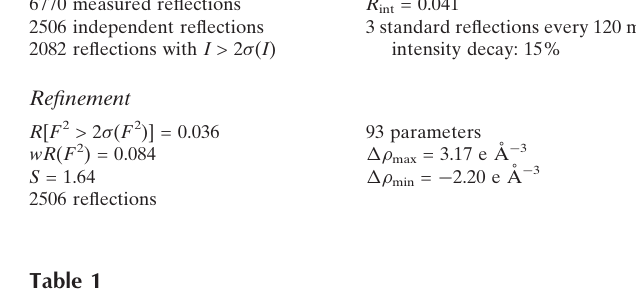
Selected bond lengths (A˚ ).